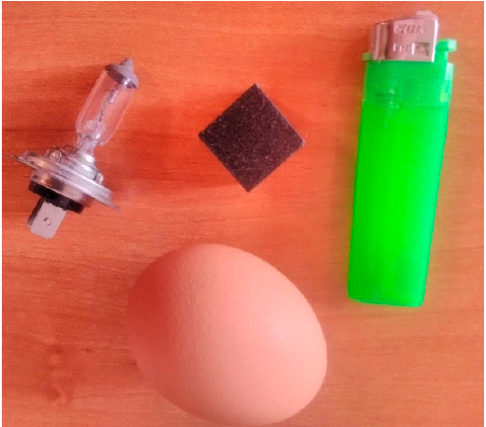
Figure 9. Items for grasping.